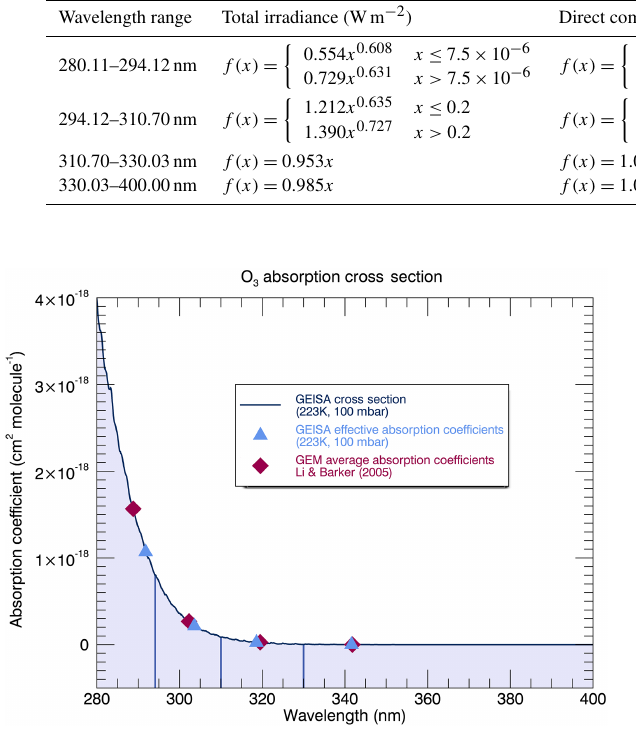
Figure 7. GEISA ozone absorption cross sections measured at a temperature and pressure of 223K and 100mbar, respectively. Overlaid are the effective absorption coefficients calculated from the GEISA cross section, as described in Sect. 3.1.1, and the GEM average absorption coefficients for each representative UV broad- band